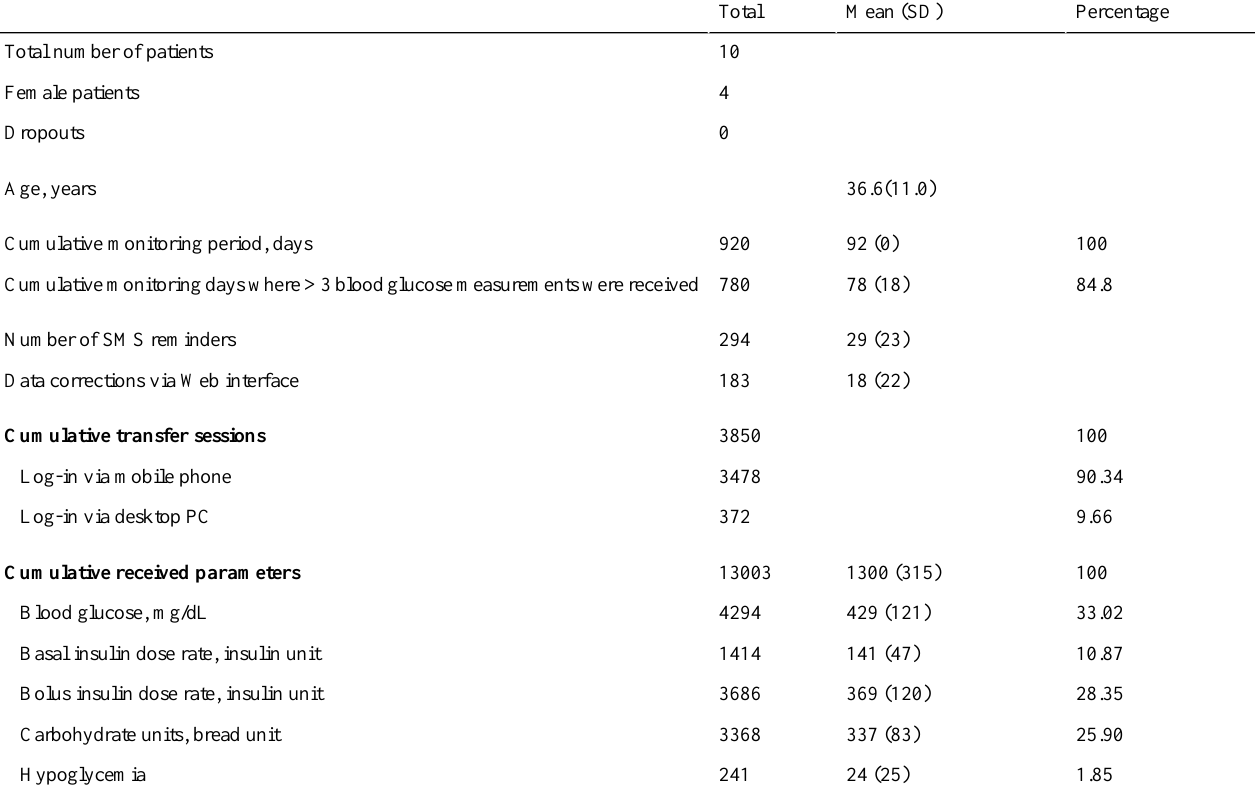
Table 1. Patient characteristics and monitoring